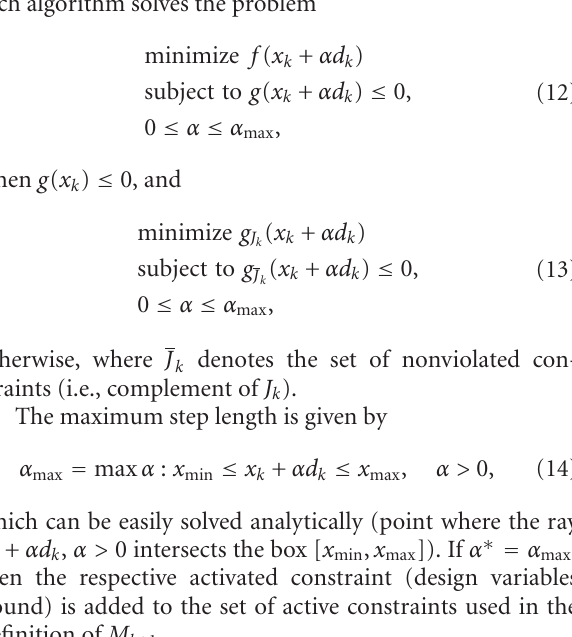
Table 2: Specifications and optimal antenna